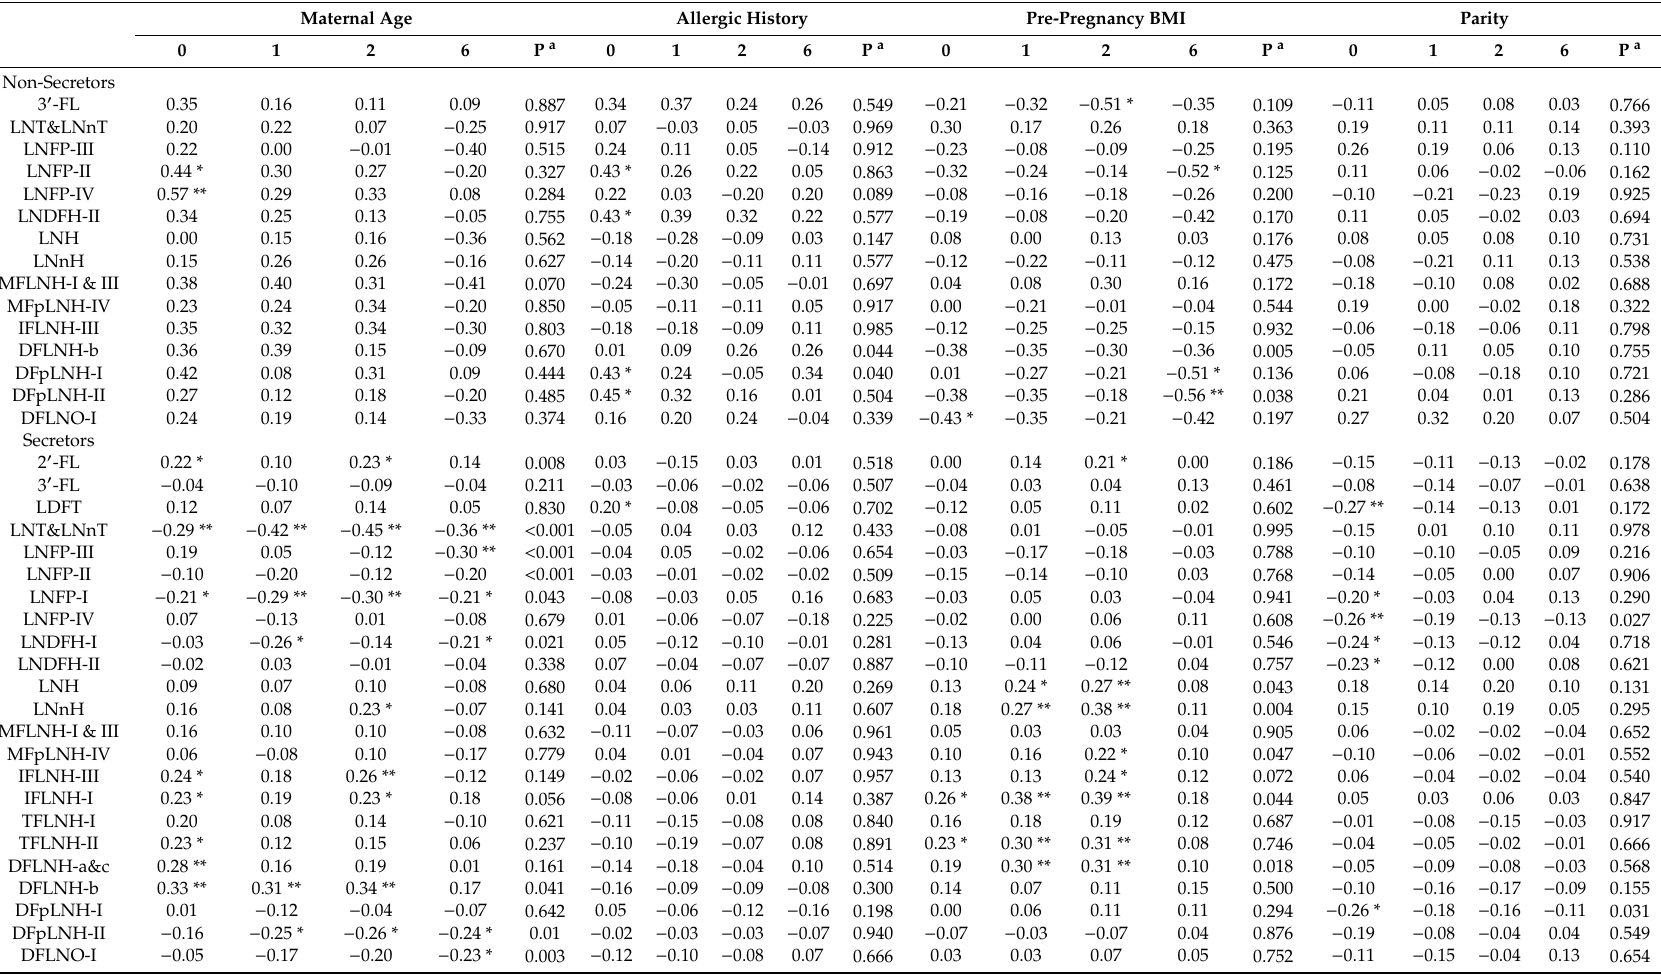
Table 3. Associations of Maternal and Infant Factors with individual HMO Concentration according to secretor